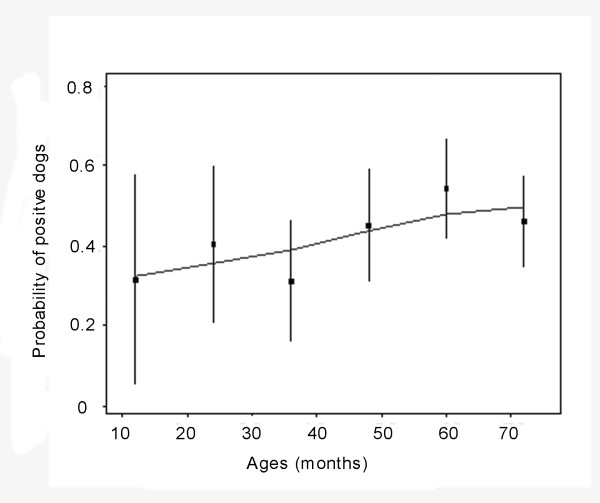
Relationship between ages of dogs and the seropositivity of T. gondii exposure. The animals were divided into 6 age groups (< 12, [12-60], ≥ 60 months) and lines represent estimated probability of seropositivity depending on age at 95% confidence intervals.